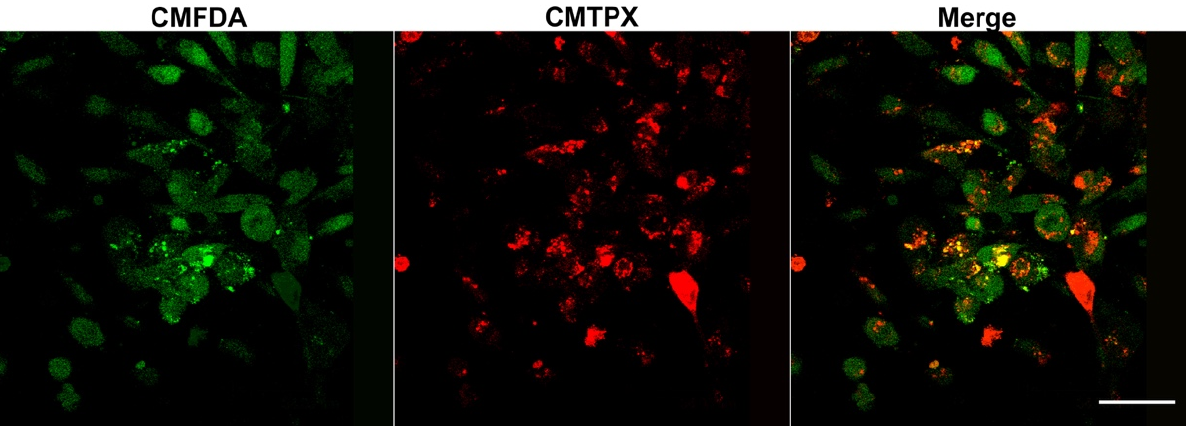
Figure A1 .—MCF-10A cells engulf MDA-MB-231 cells after both are treated with PS-AuNP. MCF-10A and MDA-MB-231 cells were stained with Cell Tracker Green (CMFDA) and Cell Tracker Red (CMTPX), respectively. The cells were then trypsinized, co-seeded in a glass bottom 4-well chamber, and allowed to adhere overnight. Finally, the cells were challenged with 150 nM of PS-AuNP for 72 h and imaged.